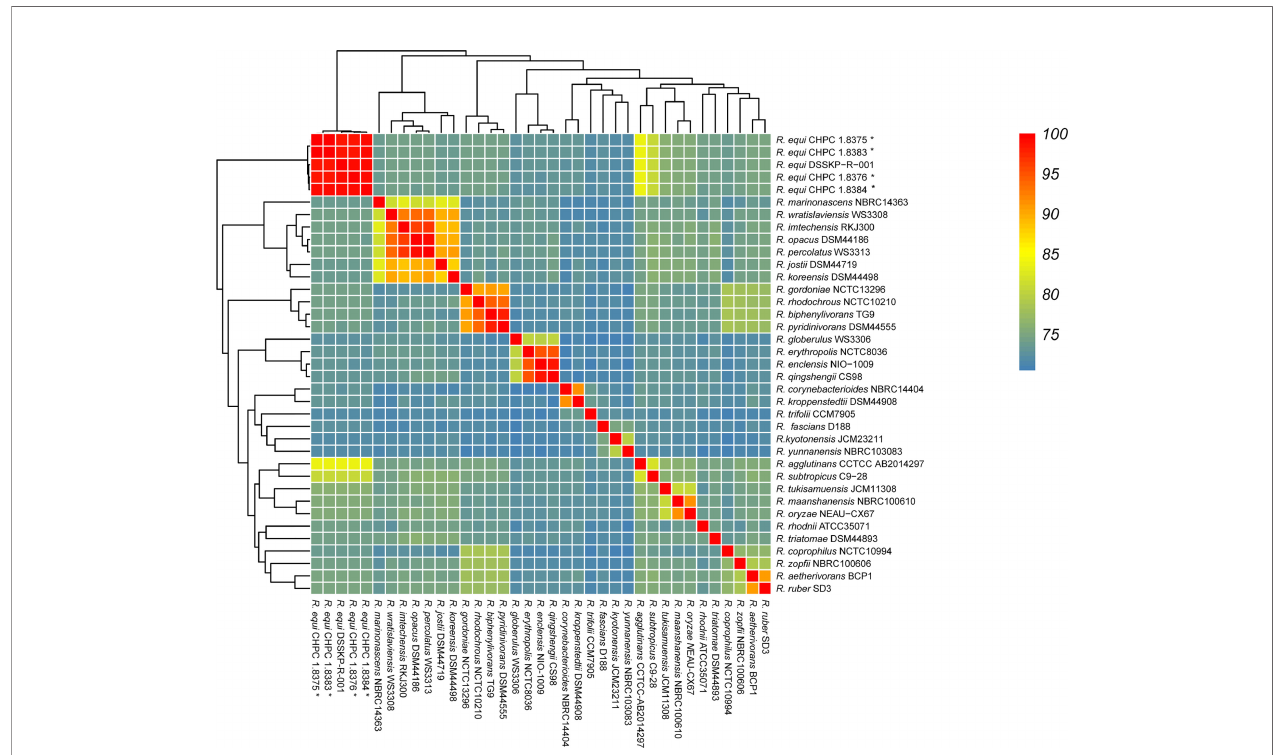
FIGURE 2 | Average Nucleotide Identity (ANI) analysis of the genomes of 37 Rhodococcus strains, the strains sequenced in this study were marked with